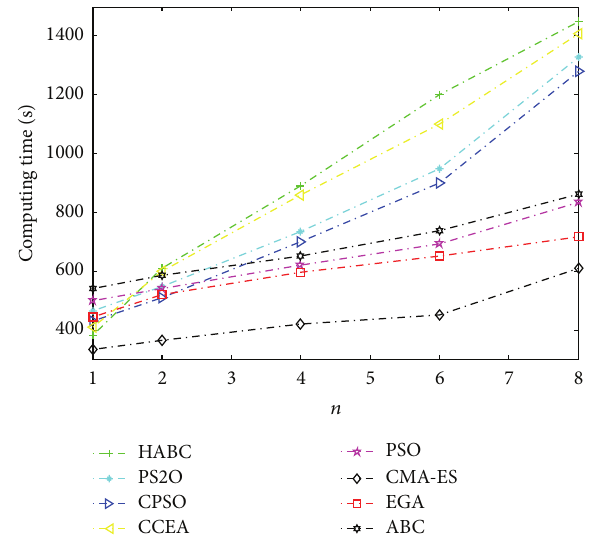
Figure 16: Computing time of all algorithms on different RNP